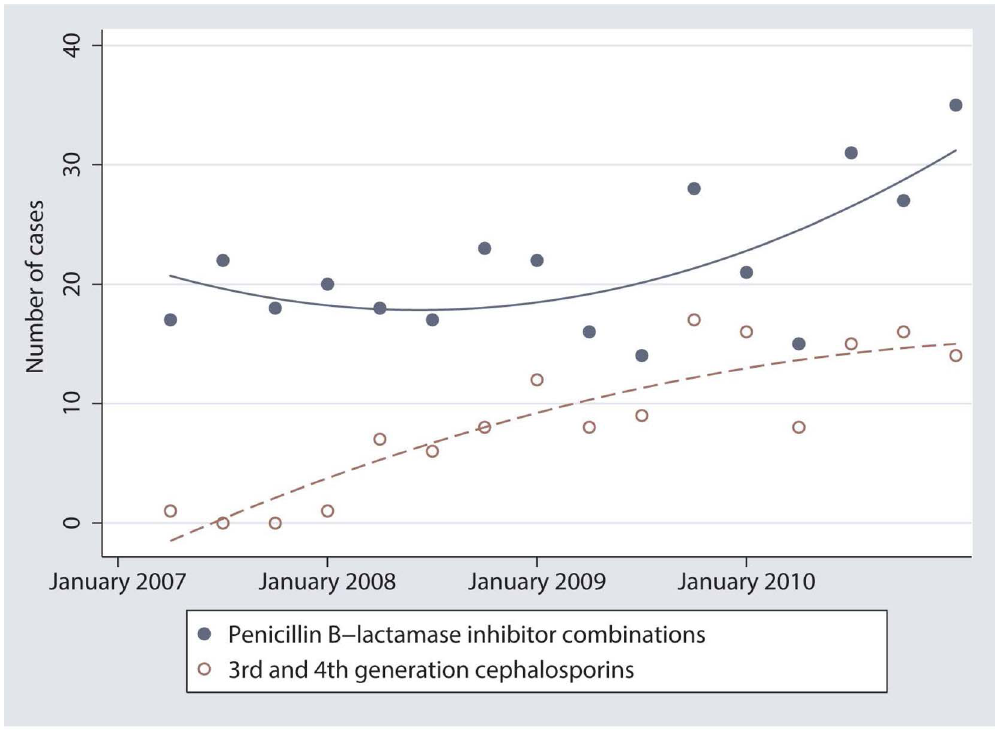
Figure 3. From 15,928 cases of companion animals with diarrhea, scattergrams of the counts of cases treated with B-lactam inhibitors and cephalosporins in each yearly quarter from January 1, 2007 to December 31, 2010.